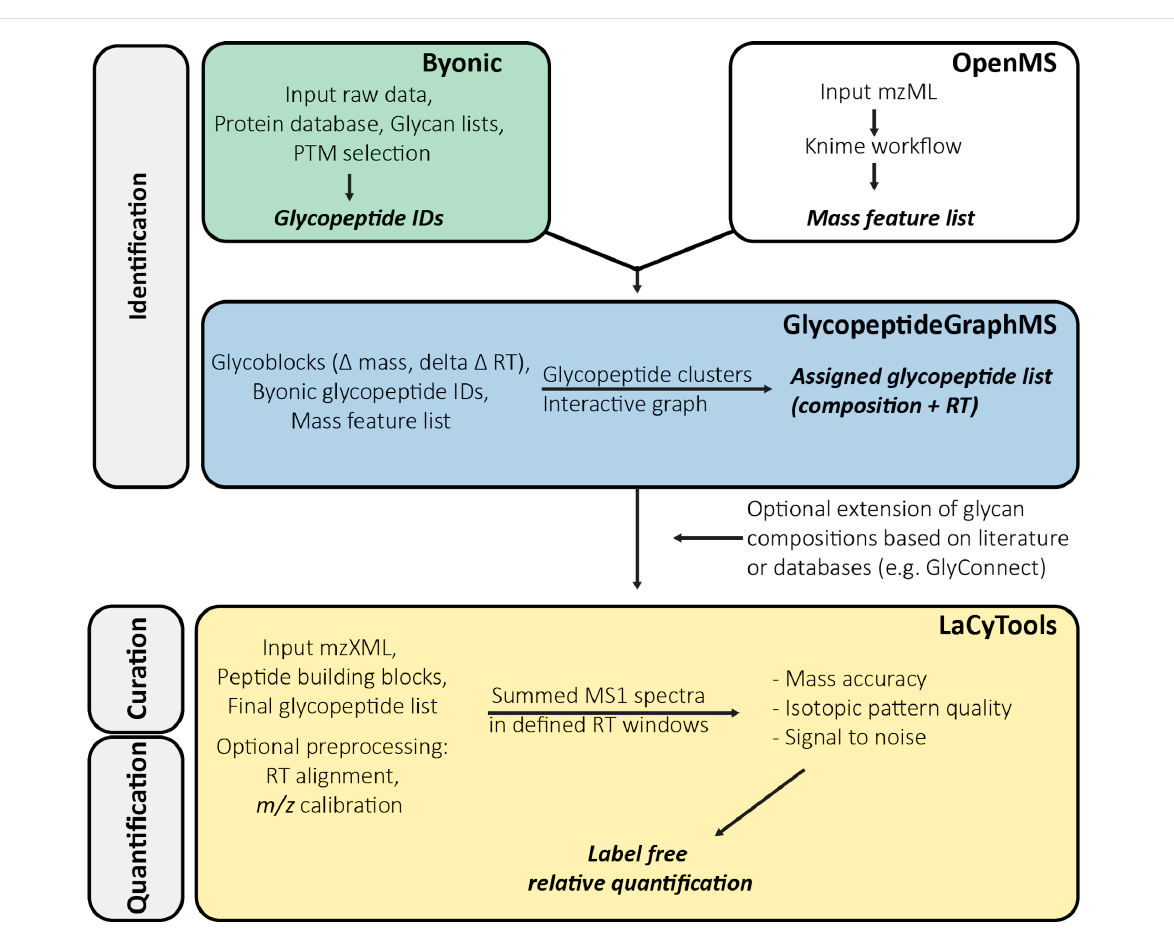
and unexpected glycopeptide clusters (e.g., missed